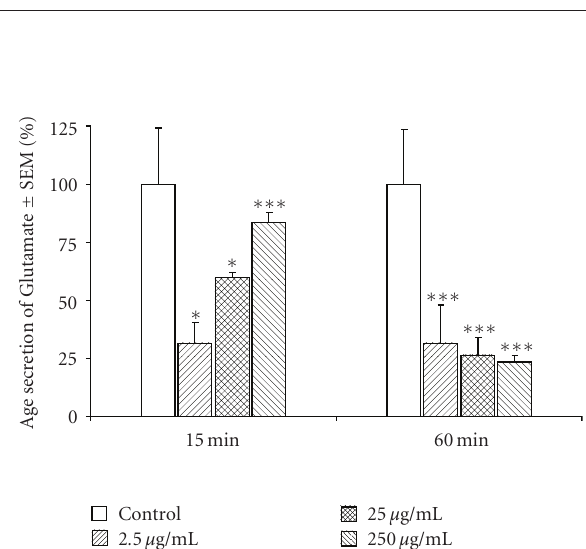
Figure 2: E ff ect produced by di ff erent concentrations (2.5, 25, and 250 μ g/mL) of methanolic extract of Nigella sativa on GABA release from cortical neurons. The cells were stimulated for 15 and 60minutes with each concentration. The values are expressed as a percentage of secretion with respect to basal value (100%). Statisti- cal significances were calculated with respect to the corresponding control at its respective time points: ∗∗ P < . 01; ∗∗∗ P < . 001.